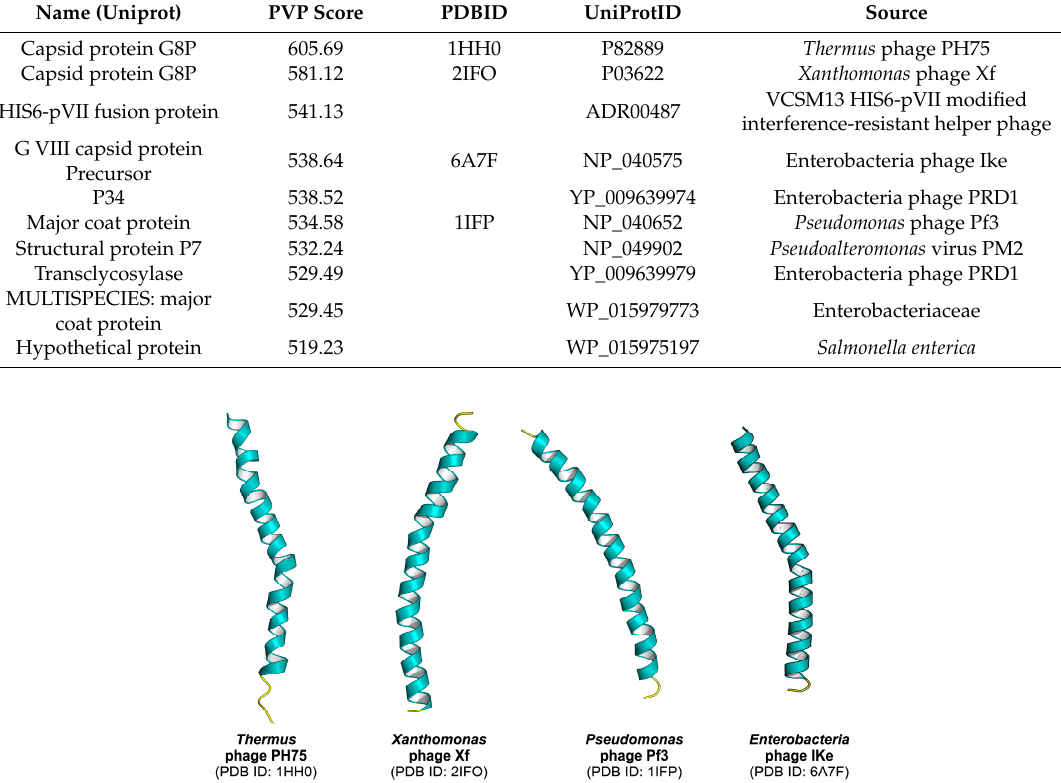
Figure 4. Structures of selected PVPs elucidated via the fiber diffraction method. Each structure is labeled by a common name followed by the Protein Data Bank identification number (PDB ID) in parenthesis on the subsequent line. Table 6. Top ten potential phage virion proteins having the highest of their PVP scores.